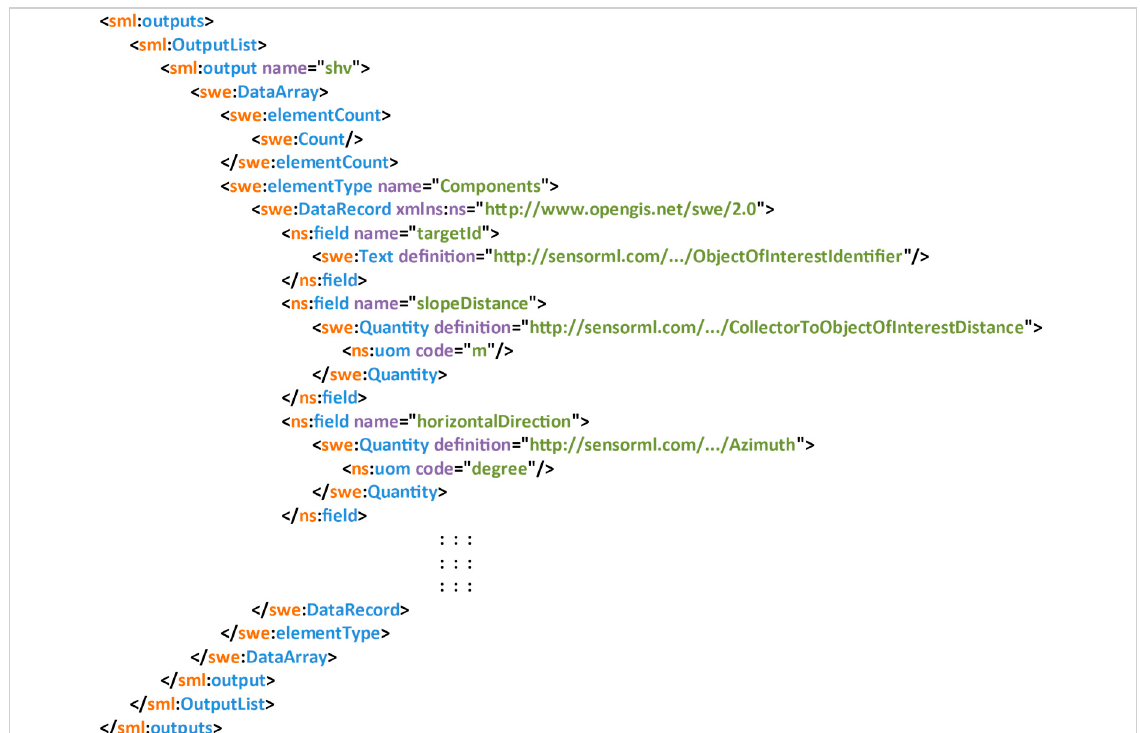
Figure 9. Insert sensor XML request, output property (SOS-SensorML2.0).